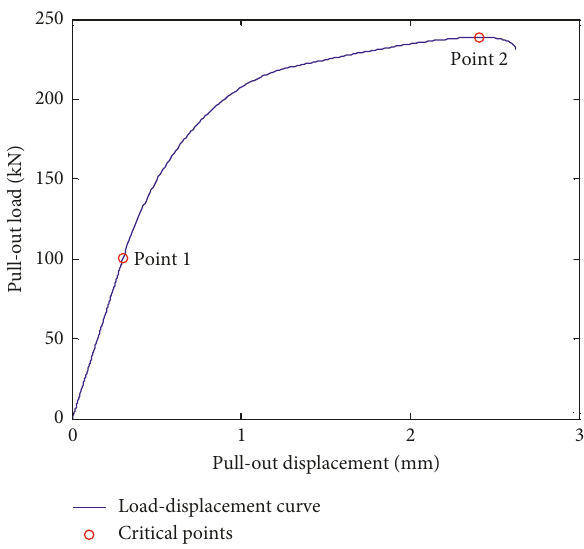
Figure 6: Selecting critical points to calibrate the input bond-slip parameters.